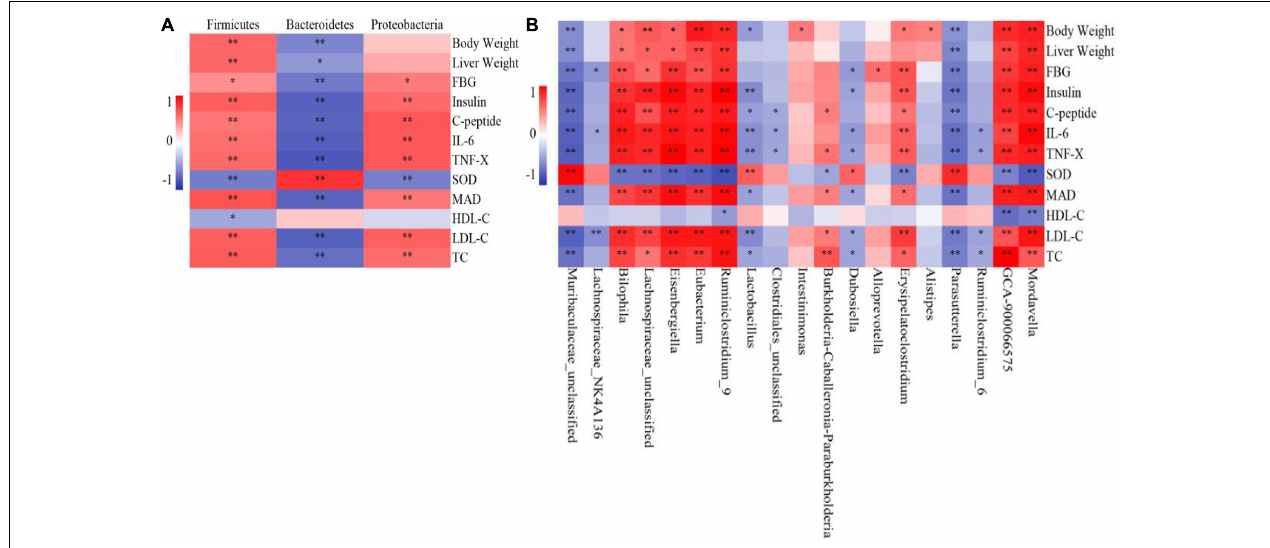
FIGURE 8 | Correlation analysis of intestinal flora and biochemical indices ( n = 6). (A) Phylum, (B) Genus. * P < 0.05, ** P < 0.01.